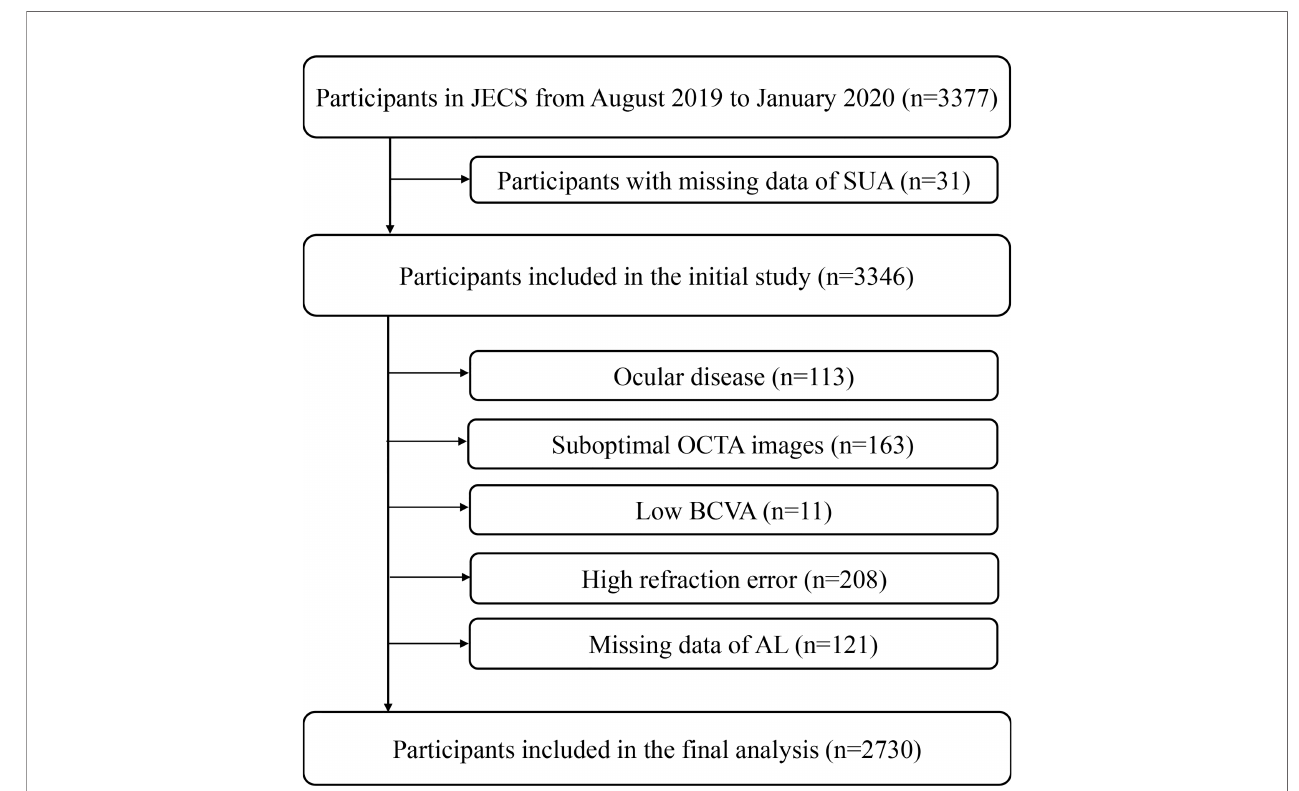
FIGURE 1 | Flow Chart of the Study Participant. JECS, Jidong Eye Cohort Study; OCTA, optical coherence tomography angiography; BCVA, best corrected visual acuity; AL, axial